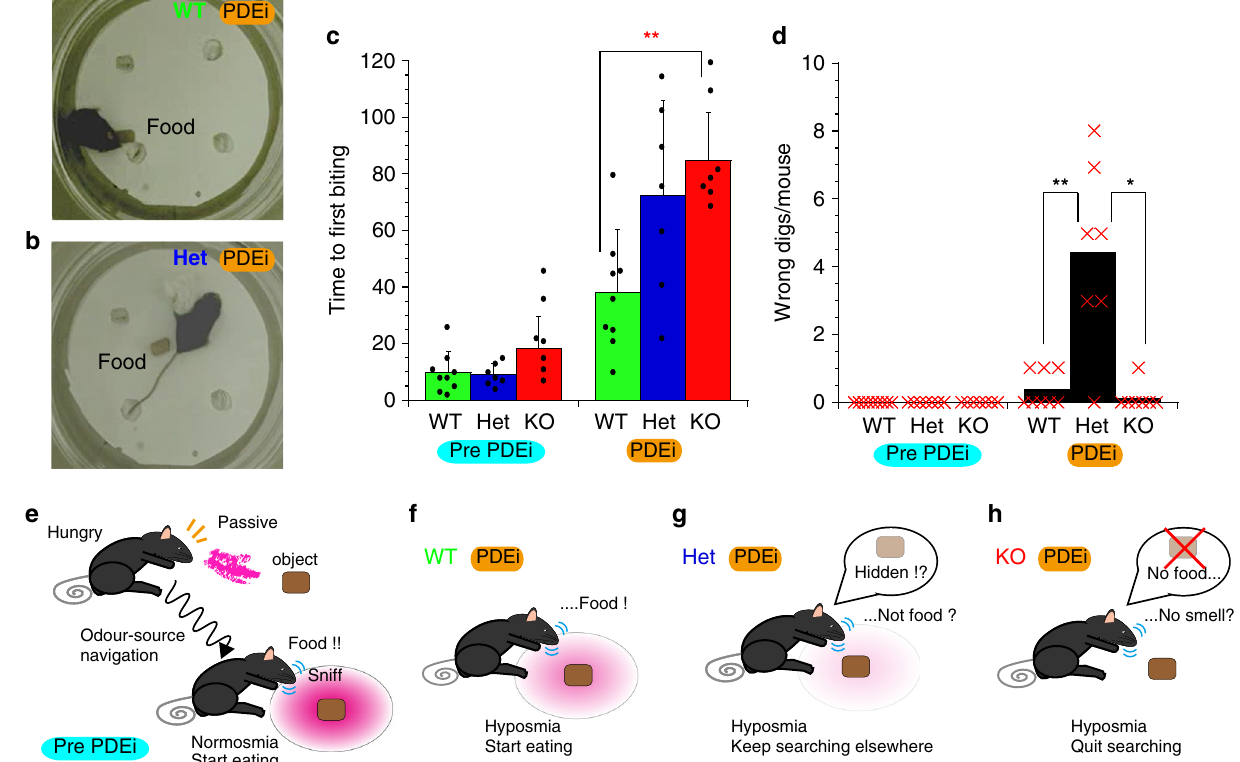
Fig. 10 OMP-de fi cient mice lose olfactory sensitivity by cAMP overload. a Eating behaviour of a WT mouse challenged with a PDEi. b Random-search behaviour of a Het mouse challenged with a PDEi. c Time to the fi rst biting of visible food without and with a PDEi (control vs post PDEi). Mean ± s.d. d The total number of wrong digs by mice challenged without and with a PDEi (control vs post PDEi). Diamonds and X-marks indicate the numbers of mice used in ( c , d ). n = 9, 7 and 7 animals in ( c ) and ( d ) for WT, Het and KO mice, respectively. * P < 0.05; ** P < 0.01. e Strategy of the visible odour-source navigation of WT, Het and KO mice in ( c ) prior to PDEi administration. f – h Interpretation of the behaviours of f WT, g Het and h KO mice challenged with a PDEi. * P < 0.05, ** P < 0.01. Statistics: c across groups (Pre); one-way ANOVA; F (3, 22) = 4.999, P = 0.017; post hoc Bonferroni test, P WT vs Het > 0.999, P WT vs KO = 0.036 and P Het vs KO = 0.036: across groups (Post); one-way ANOVA, F (3, 22) = 8.196, P = 0.0025; post hoc Bonferroni test, P WT vs Het = 0.04, P = 0.0028 and P = 0.85: among groups (Pre vs Post); paired two-sided T test; P = 0.0031, 0.0034 and 0.00074; n = 9, 7 and WT vs KO Het vs KO Control vs PDEi 7 for WT, Het and KO mice, respectively. d Across groups (Pre); ND (not determined): across groups (Post); two-sided Kruskal – Wallis test, P = 0.00041, Mann – Whitney U test, P WT vs Het = 0.0012, P WT vs KO = 0.44 and P Het vs KO = 0.0017: among groups (Pre vs Post); P Control vs PDEi = 0.076, 0.0017 and 0.39 for WT, Het and KO